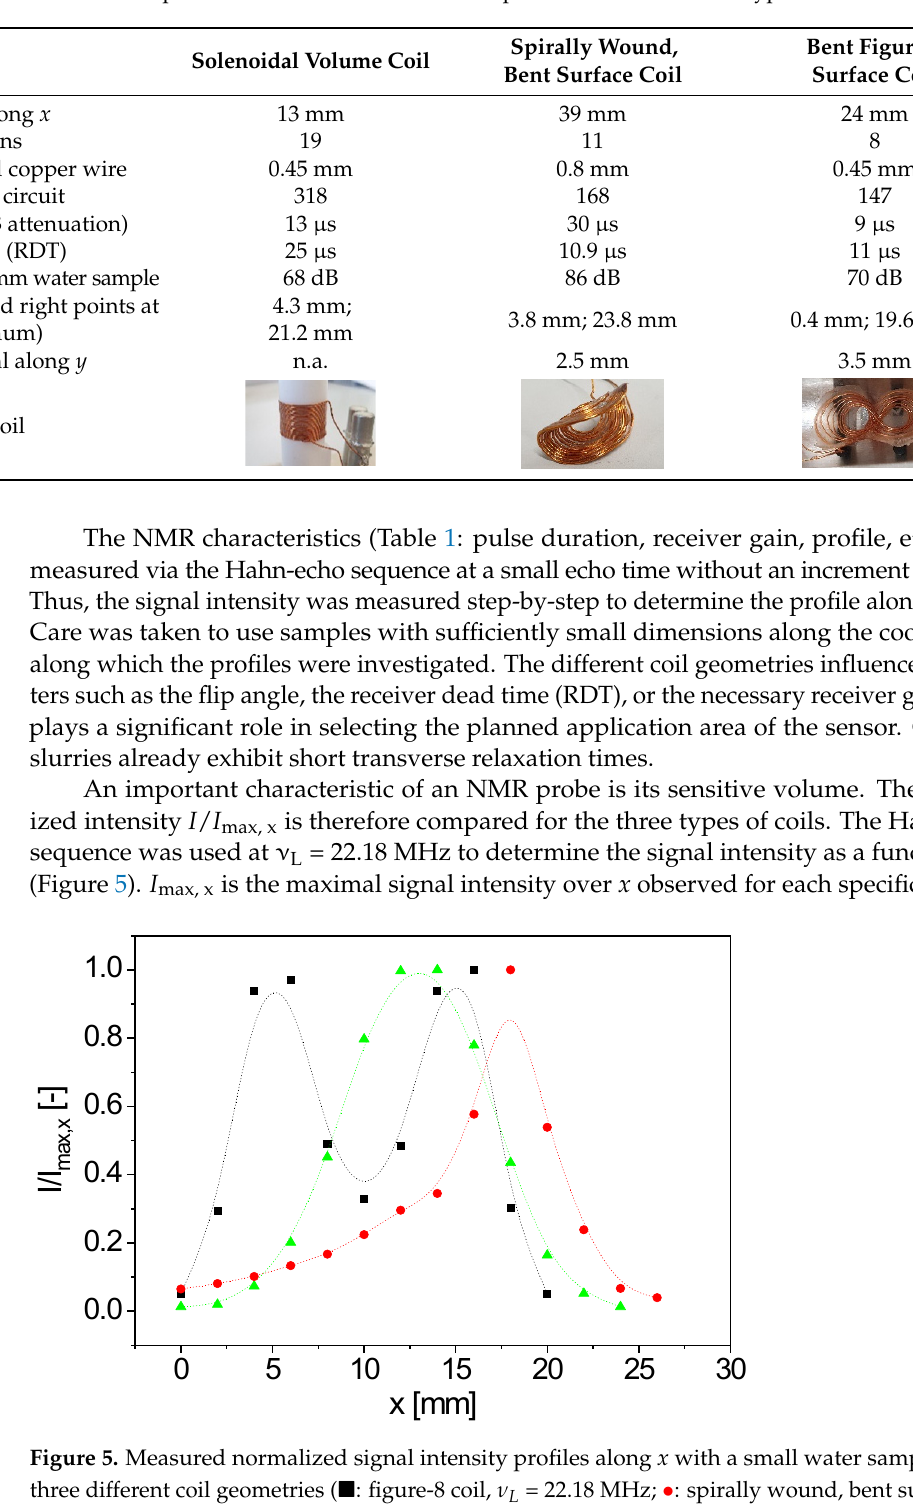
Table 1. Comparison of the technical and NMR parameters for the three types of rf coils.